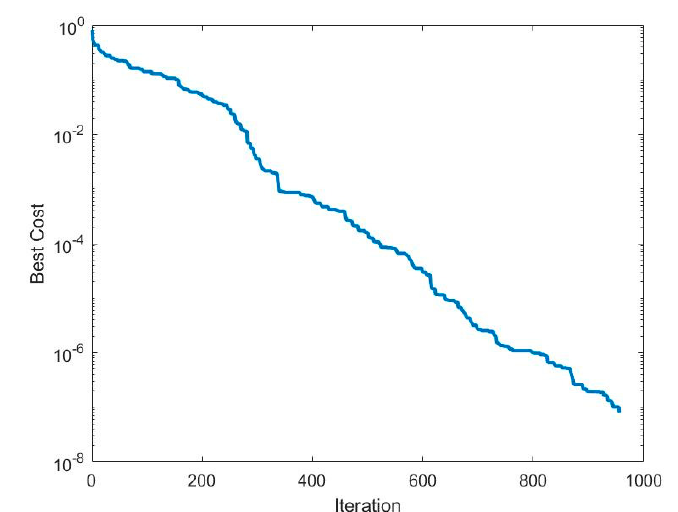
Figure 4. Plots of run 1 EE orientation.